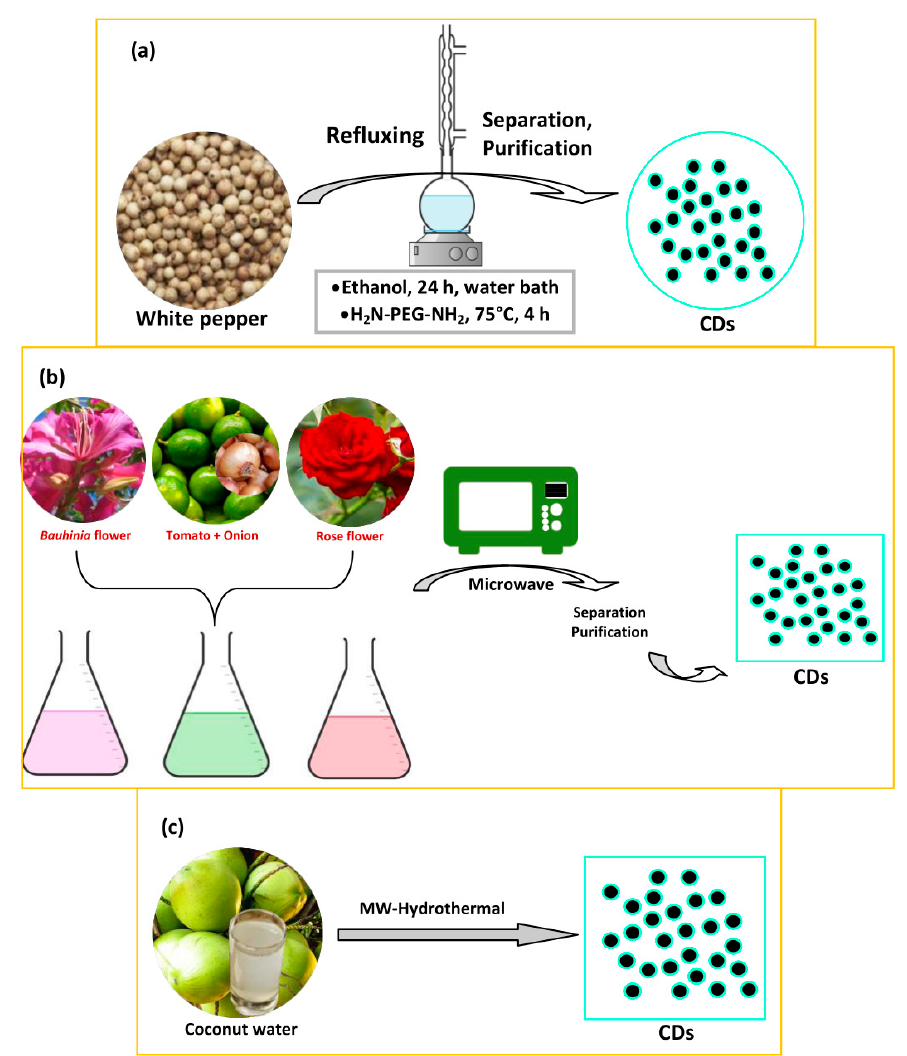
Figure 3. Synthetic procedure illustration of plant part-derived CDs by ( a ) solvothermal, ( b ) microwave, and ( c ) microwave-assisted hydrothermal methods.